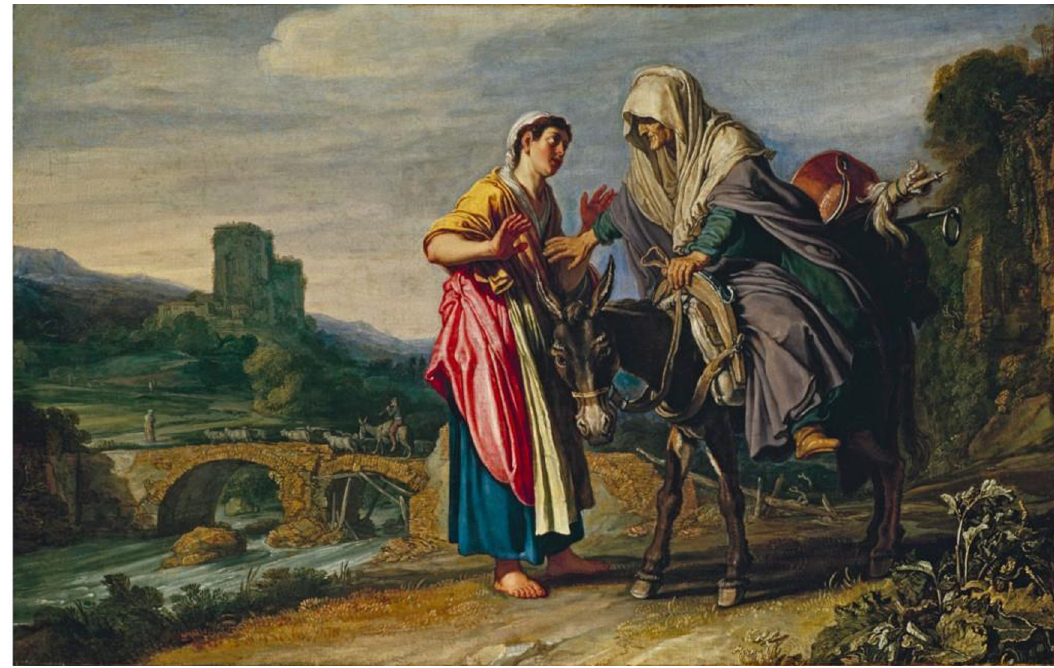
Figure 2: Pieter Lastman, Ruth Declares her Loyalty to Naomi ,